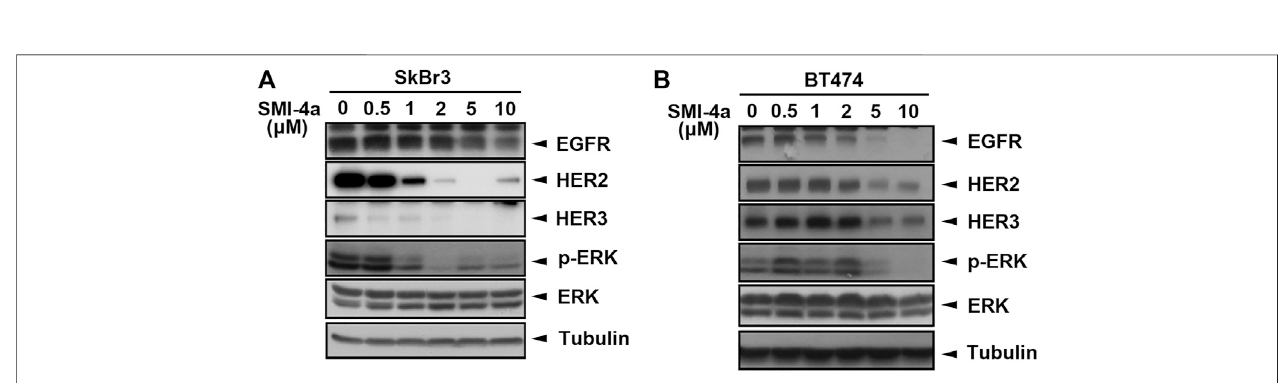
FIGURE5| Pim1inhibitorssuppressedHERfamilyexpressioninHER2-expressingbreastcancercells. (A,B) SkBr3 (A) andBT474 (B) cellsweretreatedwithSMI- 4a at 0, 0.5, 1, 2, 5, 10 μ M, and whole-cell lysates were harvested. Protein expressions were examined by western blot using the indicated antibodies.